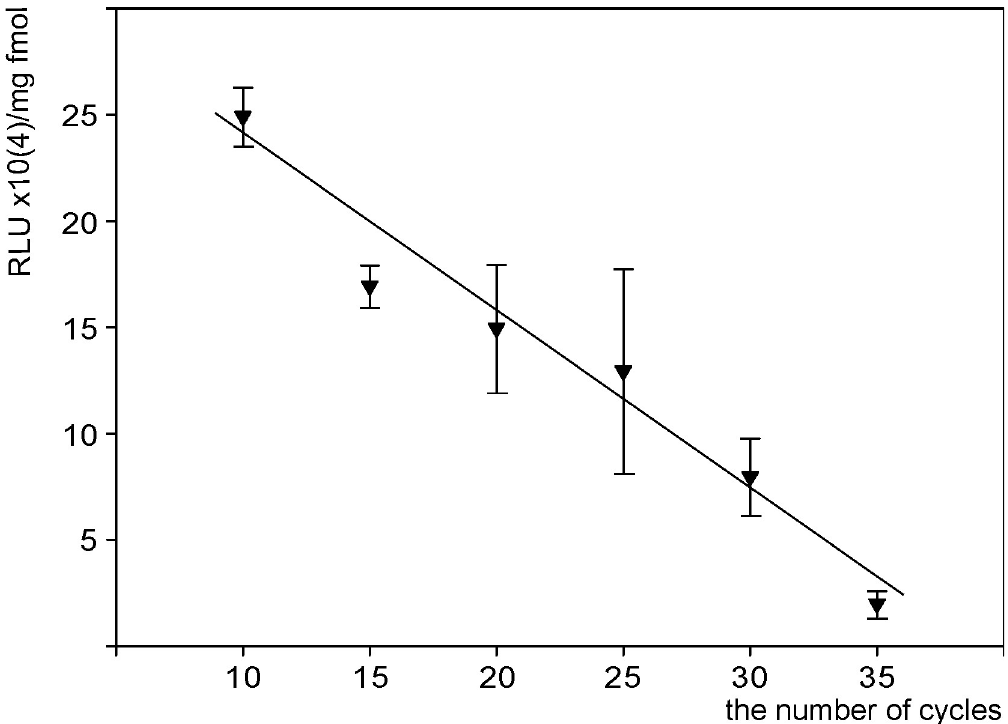
Fig 3. Accumulation of luciferase activity in HEK 293 cells after transfection by ampl-luc variants obtained using different number of PCR cycles. Abscissa: number of PCR cycles used to synthesize ampl-luc. Ordinate: luciferase activity detected in lysates of HEK293 cells 48 h after transfection. The activities were normalized to the quantities of protein in lysates and vector DNA (femtomoles) used in transfection. Transfection was carried out using 500 ng (321.5 femtomoles) of ampl-luc DNA per 50,000 HEK293 cells. The found relationship is described by the equation y = (-0.8203x + 31.75) × 10 4 with the approximation reliability R 2 = 0.9576.